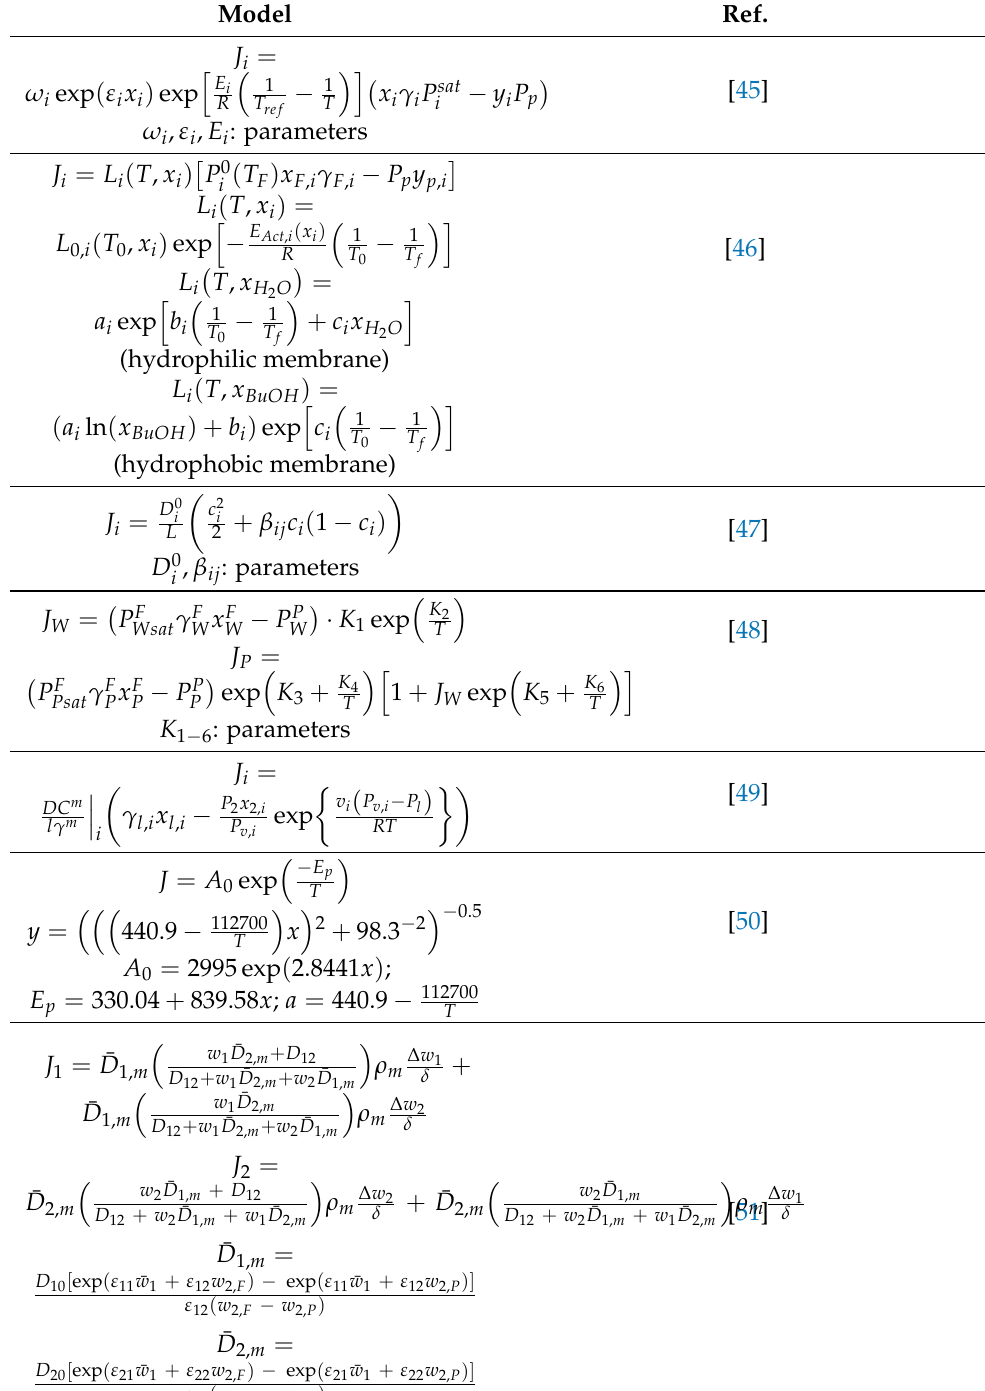
Table 1. Cont . Model